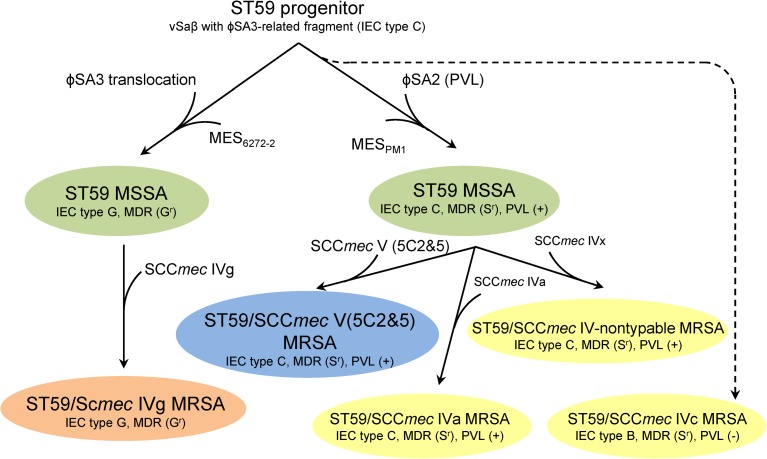
Proposed evolutionary history of CC59 S. aureus in Taiwan.SCCmec IVg MRSA, non-subtype-g SCCmec IV MRSA, SCCmec V (5C2&5) MRSA or MSSA with the characteristics found in this study are shaded in orange, yellow, blue or green, respectively. Dash line indicates an uncertain evolutionary route. MDR: multidrug resistance; Sr: streptomycin resistance; Gr: gentamicin resistance.